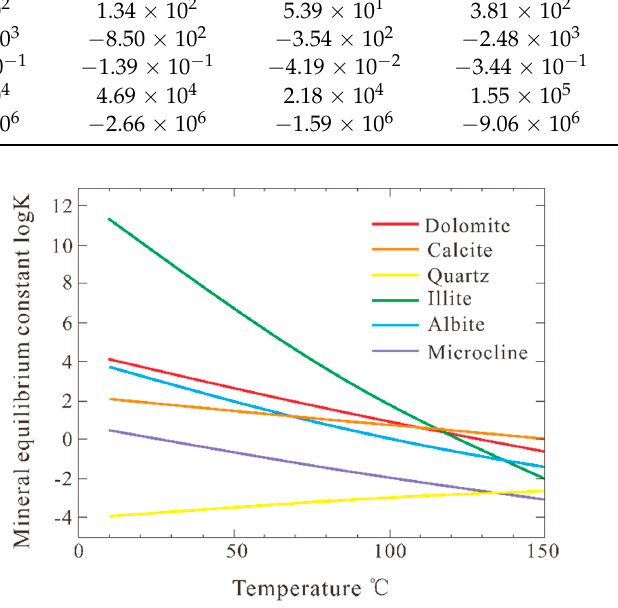
Figure 6. Variations in the dissolution equilibrium constants of the main minerals with